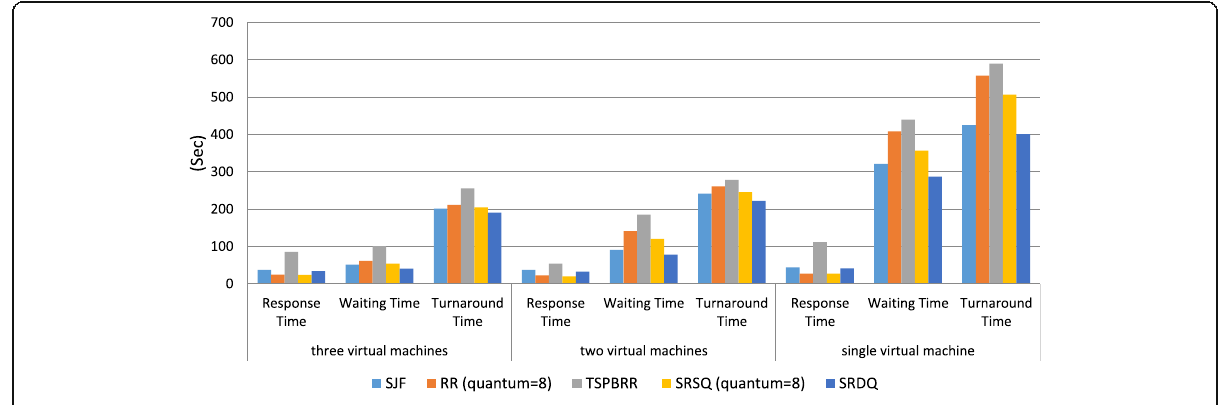
Fig. 2 Second Experimentation Results using Dataset2, on (1, 2, 3) VMs